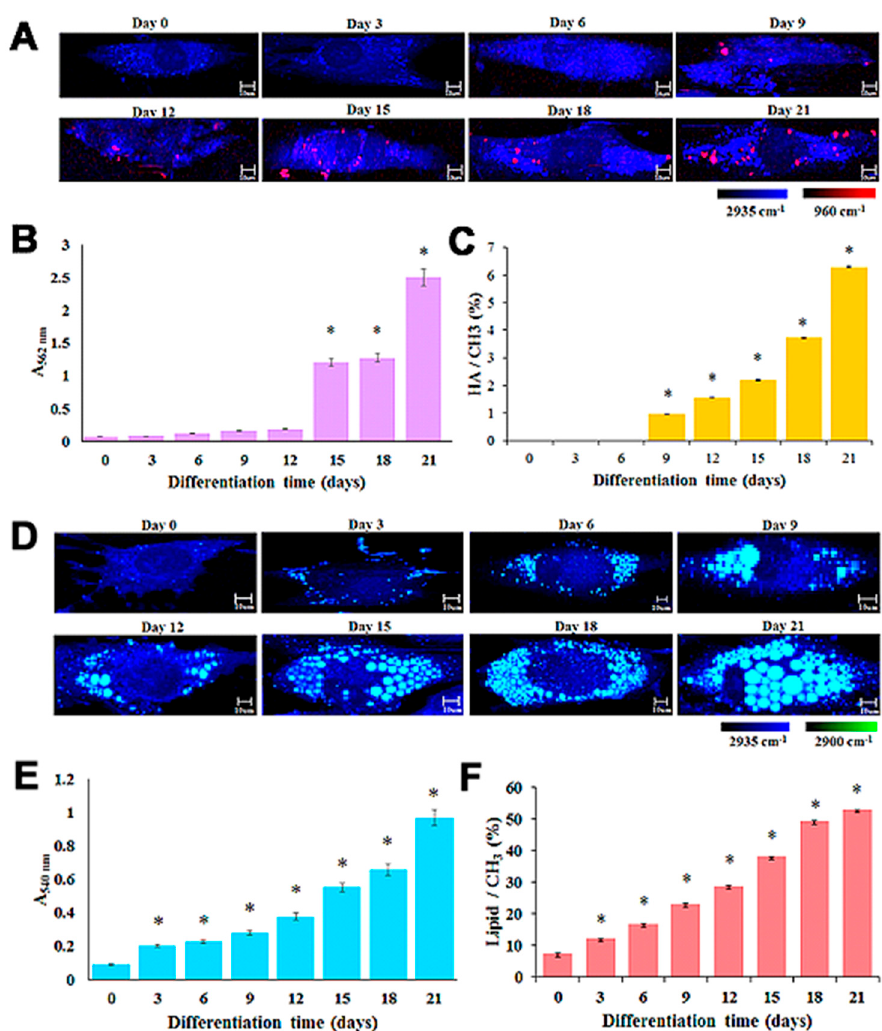
Figure 5. Label-free monitoring of MSC differentiation into osteoblasts and adipocytes in a time-dependent manner: ( A ) Raman mapping of single live osteoblast using the peak at 960 cm − 1 (referring to the presence of HA); ( B ) ARS quantification staining within an interval time of three days; ( C ) HA/CH 3 ratio based on Raman mapping analysis; ( D ) Raman mapping of single live adipocyte using the lipid peak at 2,900 cm − 1 ; ( E ) ORO quantification staining within an interval time of three days; and ( F ) lipid/CH 3 ratio based on Raman mapping analysis. Reprinted with permission from [17]. Copyright 2018,